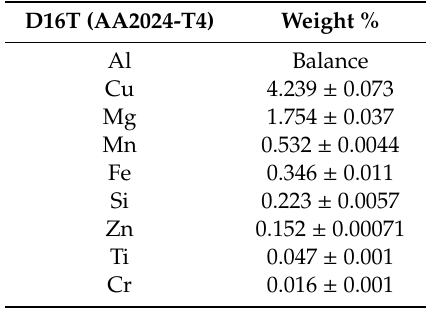
Table 1. D16T elementary